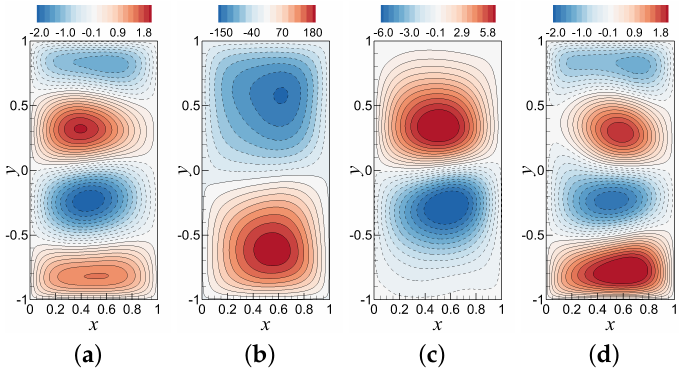
Figure 12. Mean stream function contour plots between t = 15 and t = 60 obtained by reference FOM and different ROM simulations for Re = 400 and R = 10 modes: ( a ) ψ FOM at a resolution of 128 × 256; ( b ) ψ ROM-GP ; ( c ) ψ ROM-ANN ; and ( d ) ψ ROM-H . Note that only the proposed ROM-H model has successfully captured the four-gyre